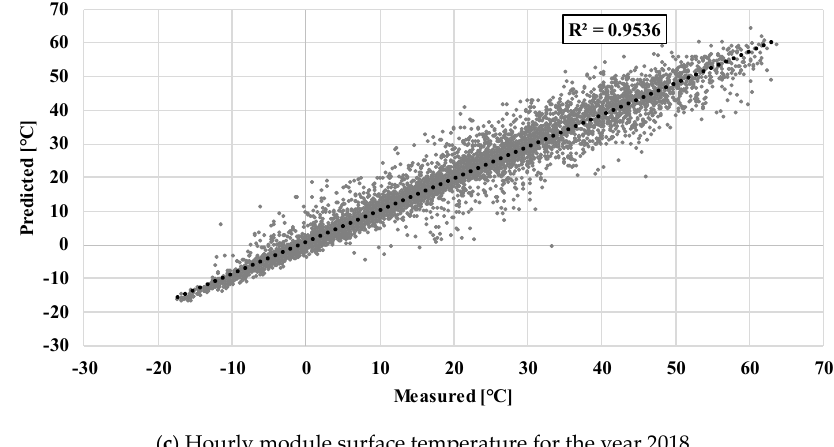
Figure 9. Comparison of the measured and predicted module surface temperatures.